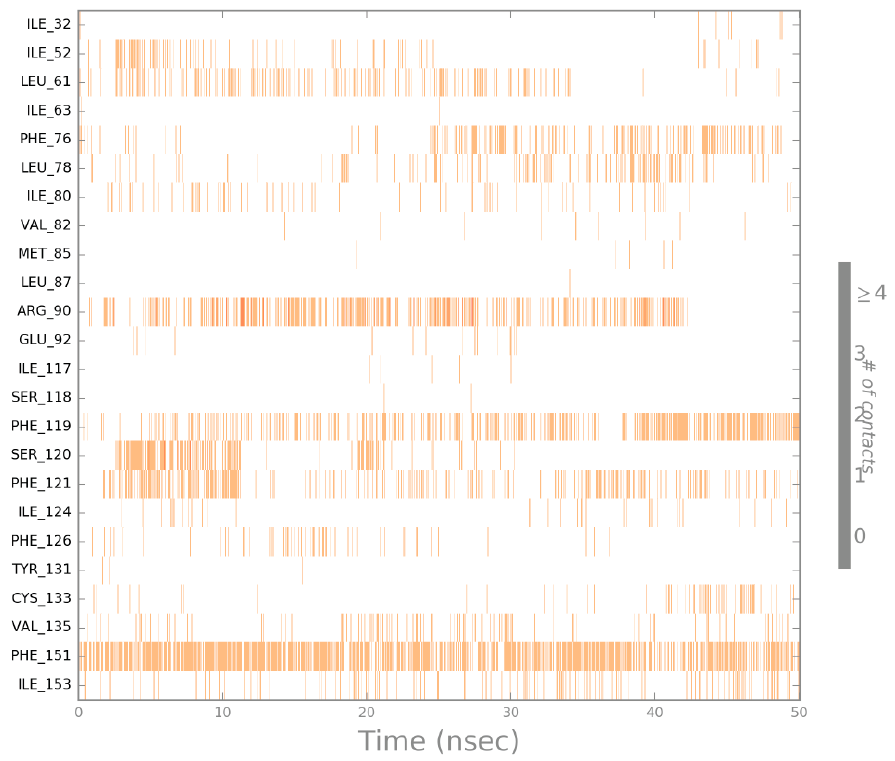
Figure 10. Interaction diagram for compound 5 and MD-2 complex obtained in molecular dynamics simulation studies.